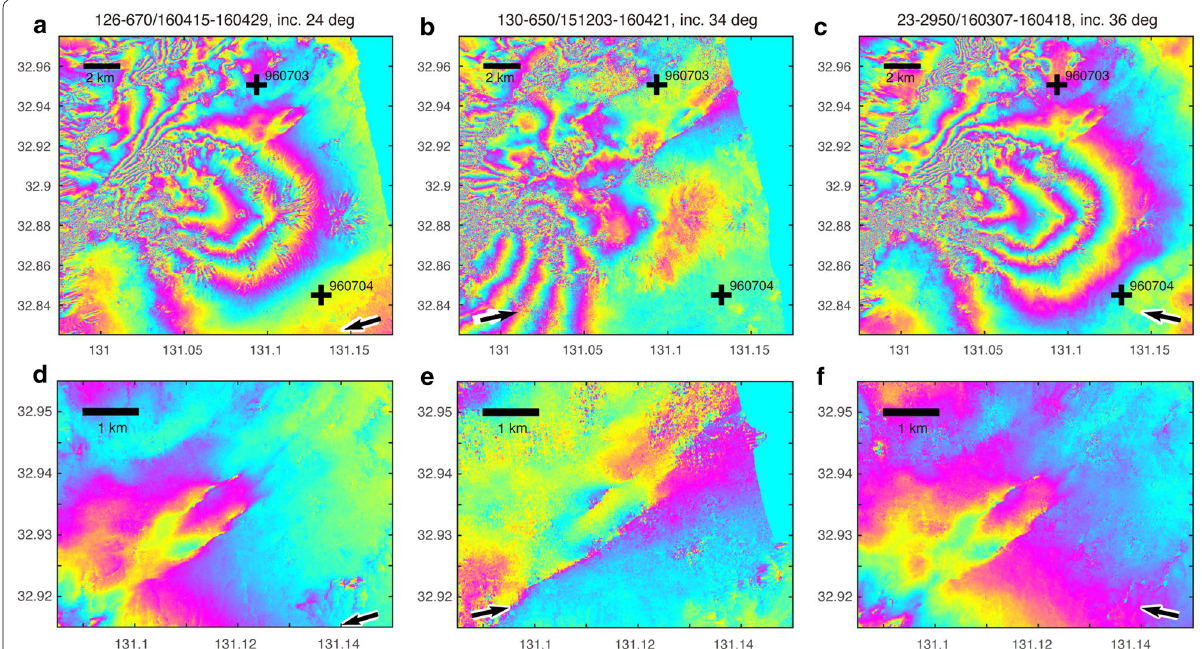
Fig. 2 (Top) Interferograms including the target area and the location of the two GEONET GNSS stations, 960703 and 960704, used for referencing the InSAR displacements. (Bottom) Zoomed-in interferograms. a , d Path 126. b , e Path 130. c , f Path 23. Same colormap as Fig. 1 applies. The arrows show the horizontal projection of the beam